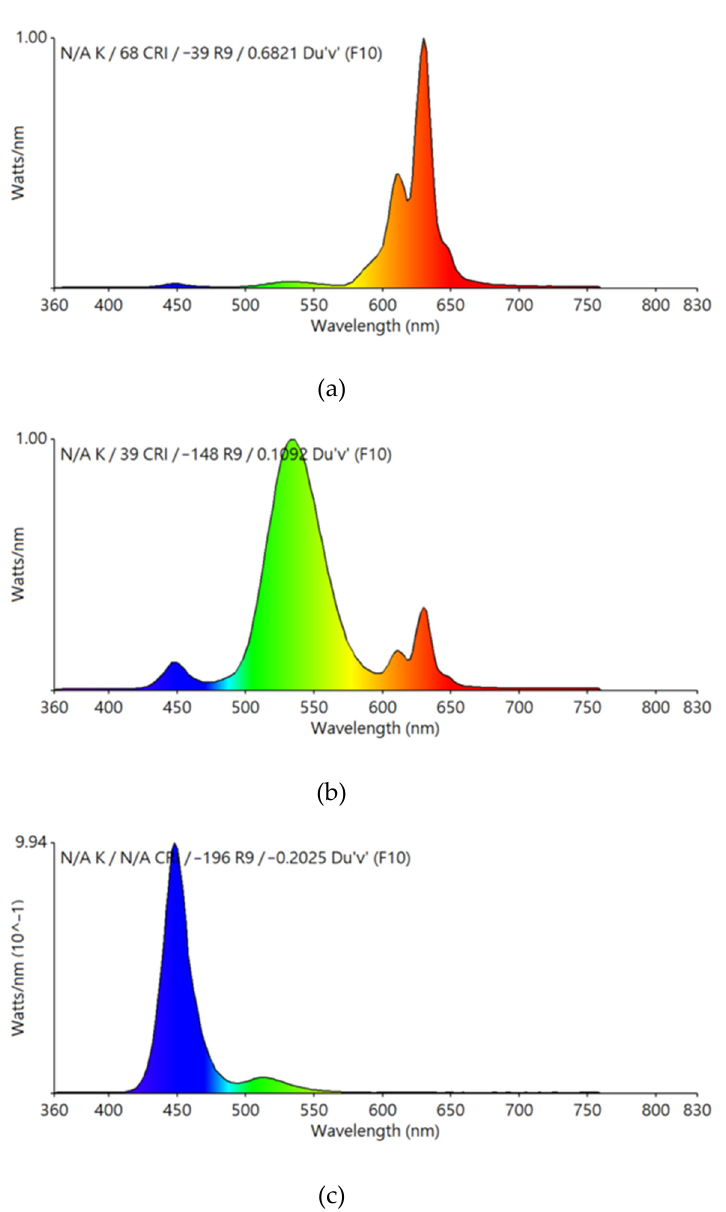
Figure 11. Spectrum of backlight element of the smart mobile device iPhone X ( a ) red light ( b ) green light ( c ) blue light.